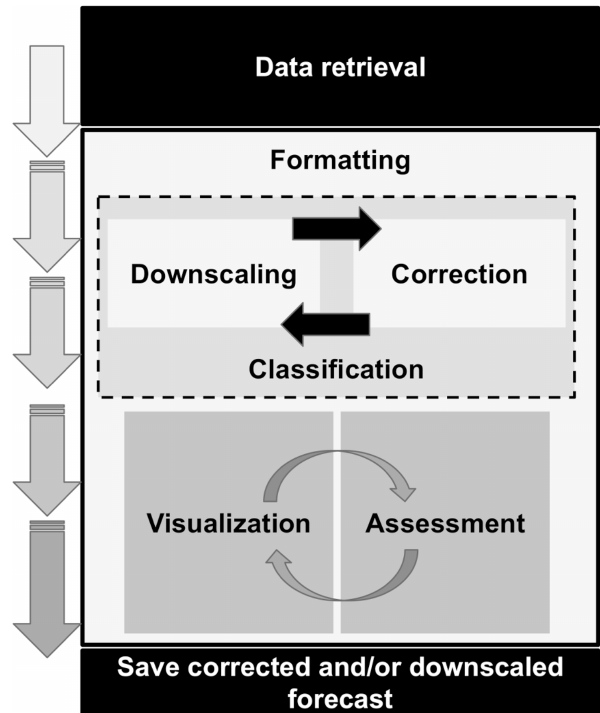
Figure 1. Scheme of the flexible CSTools workflow (from top to bottom). Each box represents a category of functions that is part of